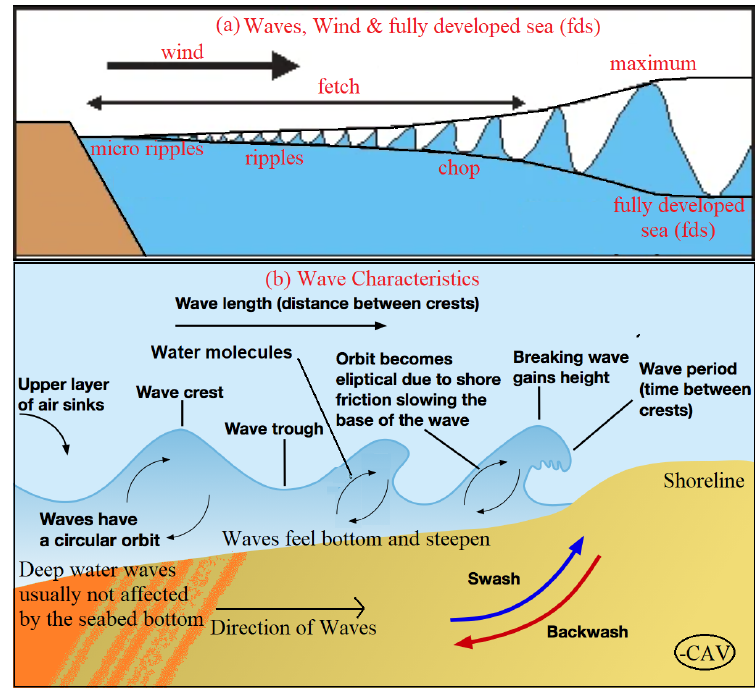
Figure 13. Illustration of: ( a ) wind, waves and Fully Developed Sea (fds) profiles, and ( b ) wave characteristics. Table 7. Wave Parameters for the 3 load Cases.